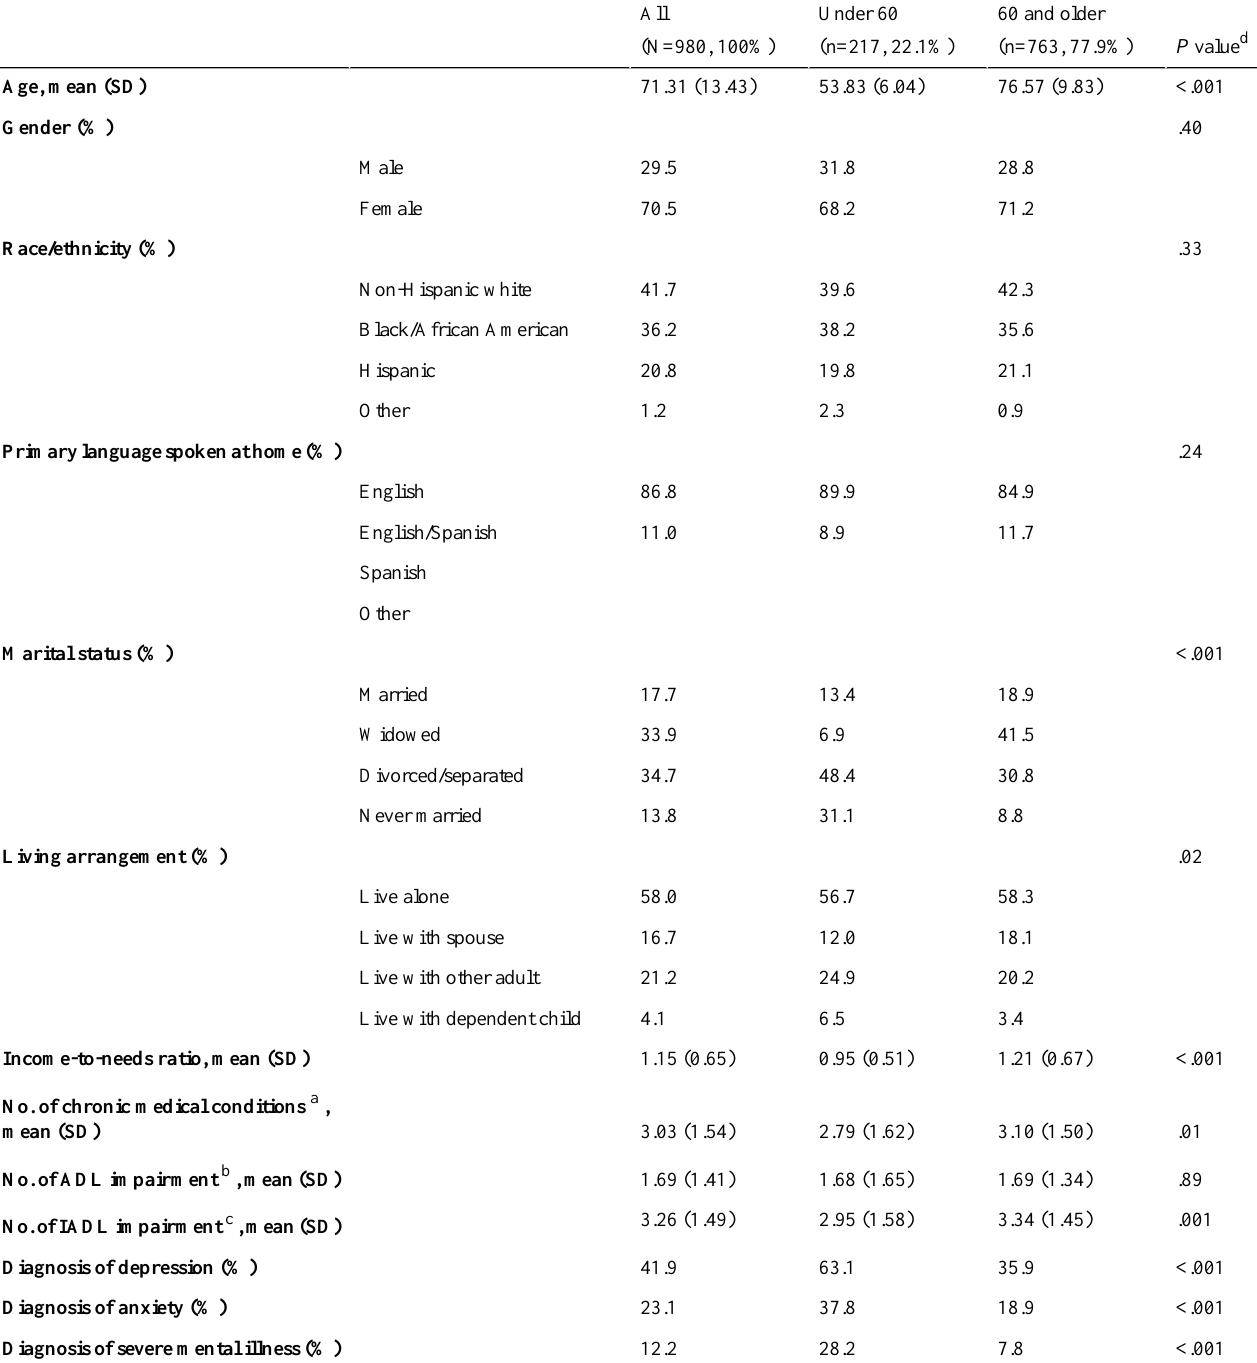
Table 1. Sociodemographic and health and mental health characteristics by age